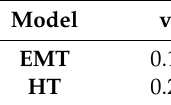
Table 2. Fitted parameters of the empirical model.